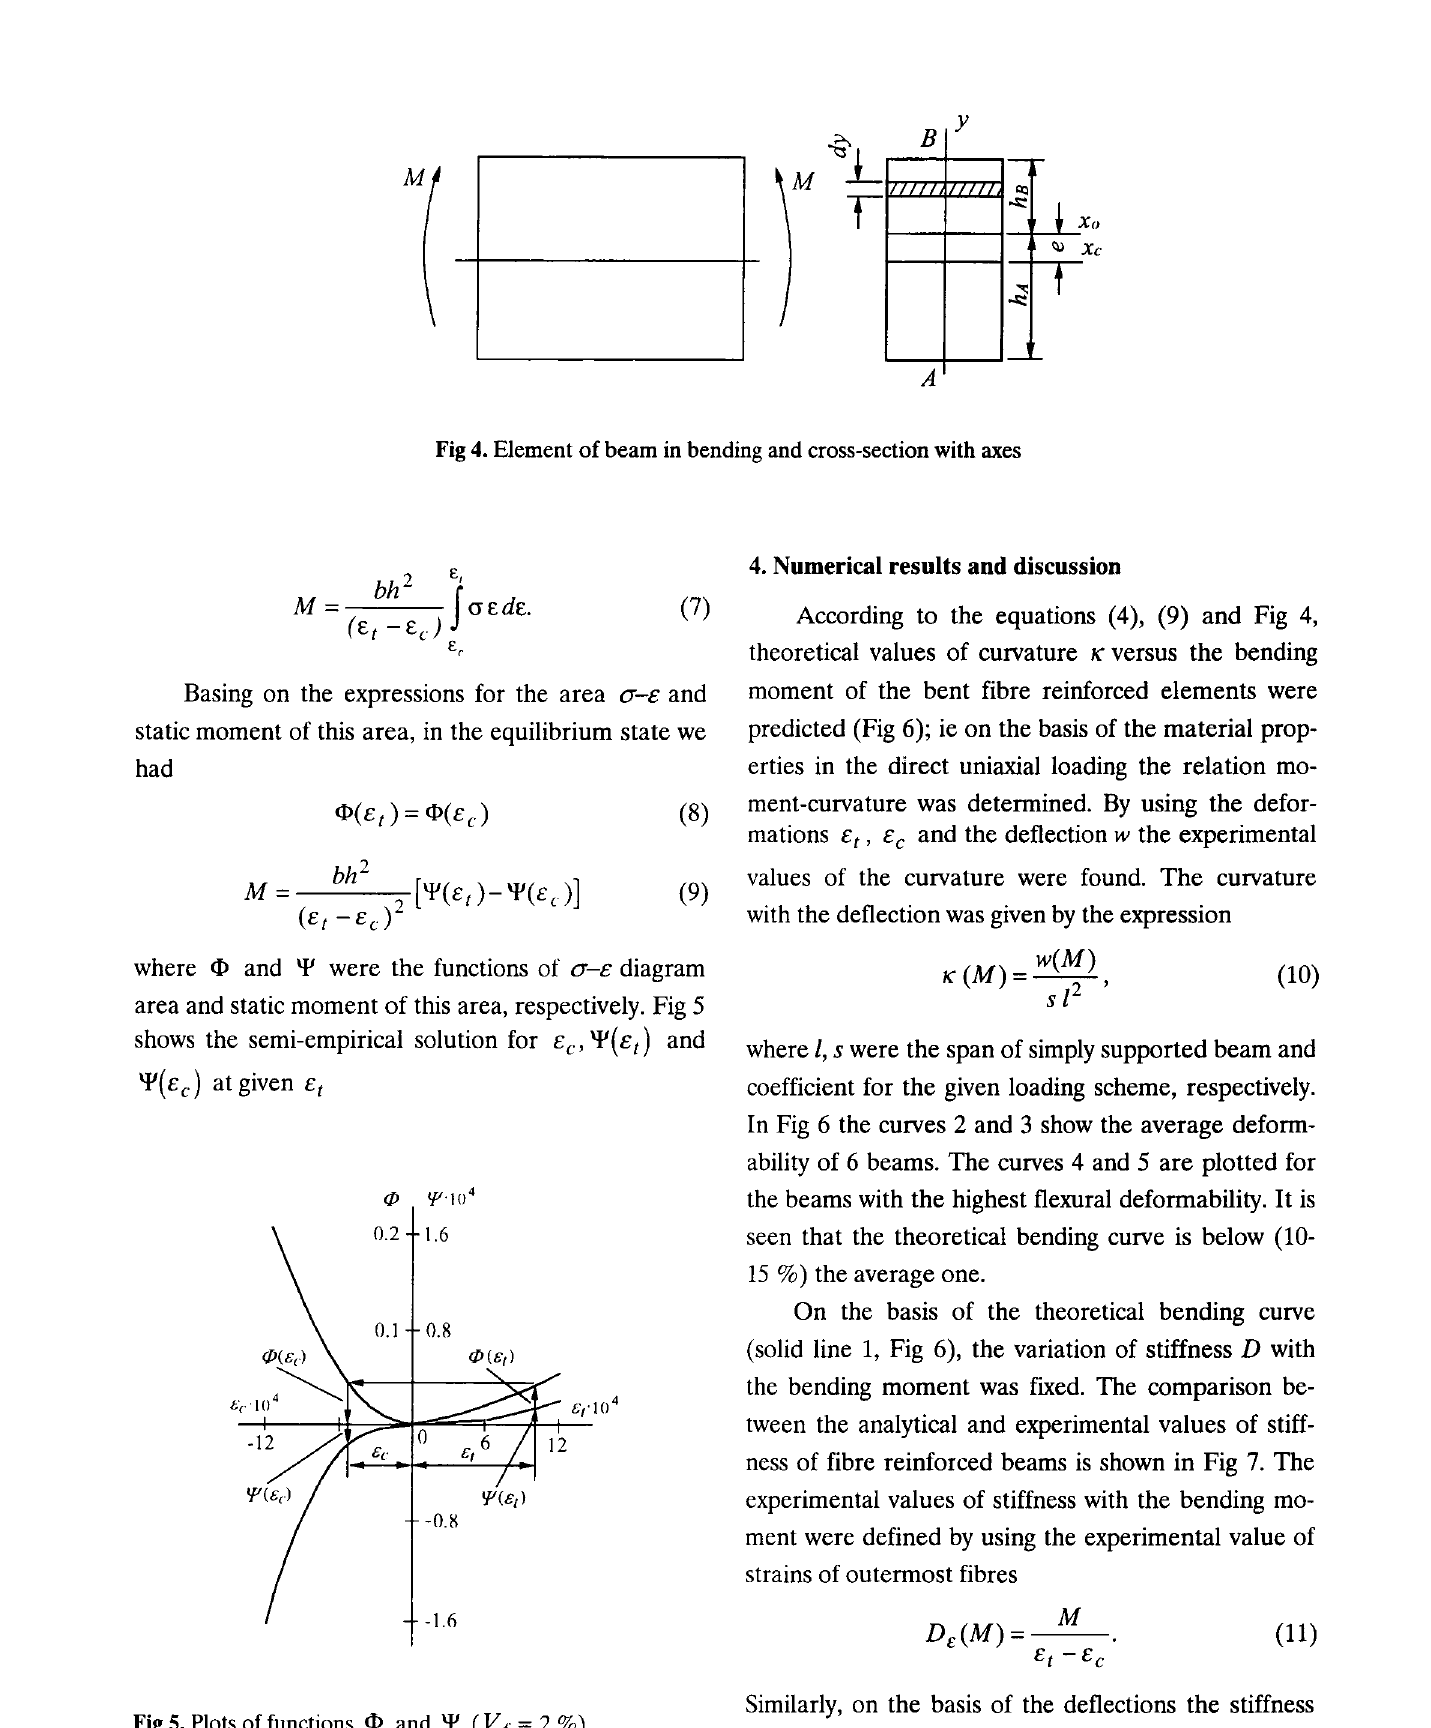
Fig 5. Plots of functions <I> and 'I' ( Vr = 2